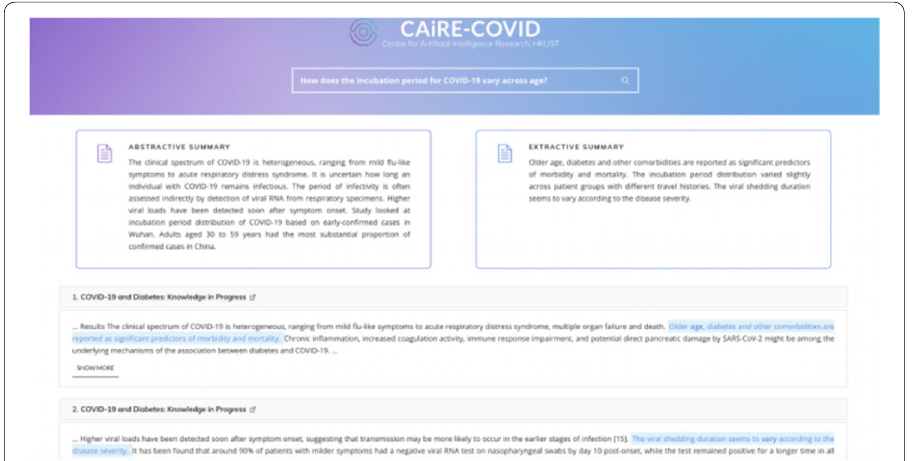
Fig. 5 User Interface for the CAiRE-COVID Literature Mining system consisting of Extractive Summary, Abstractive Summary, and most relevant documents (Image taken from Su et al.